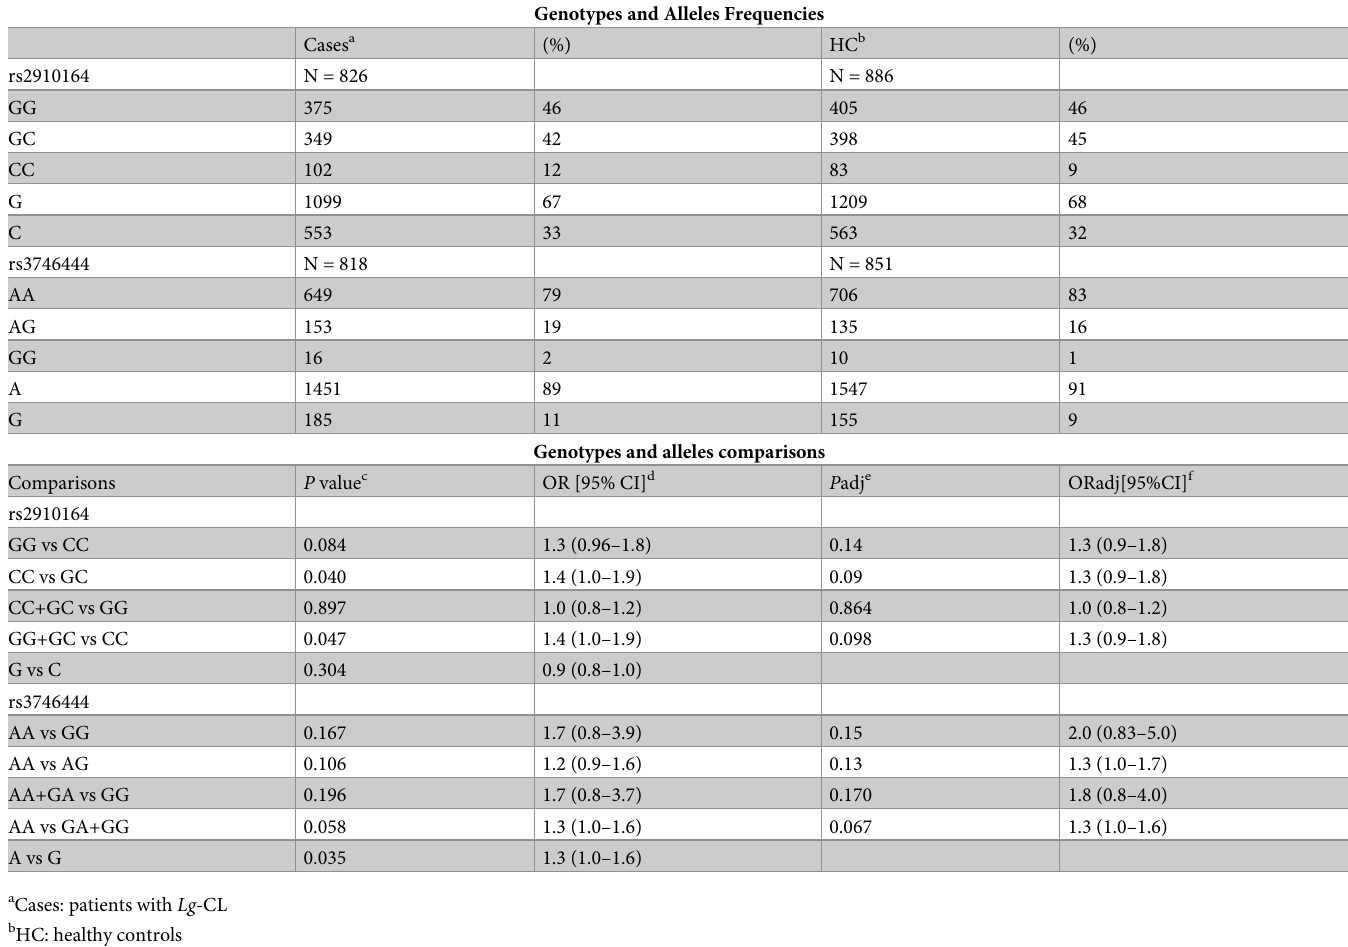
Table 1. Genotype and allele frequencies for the MIR146A rs2910164 and MIR499A rs3746444 in patients with Leishmania guyanensis -Cutaneous Leishmaniasis ( Lg -CL) and healthy controls. Genotypes and Alleles